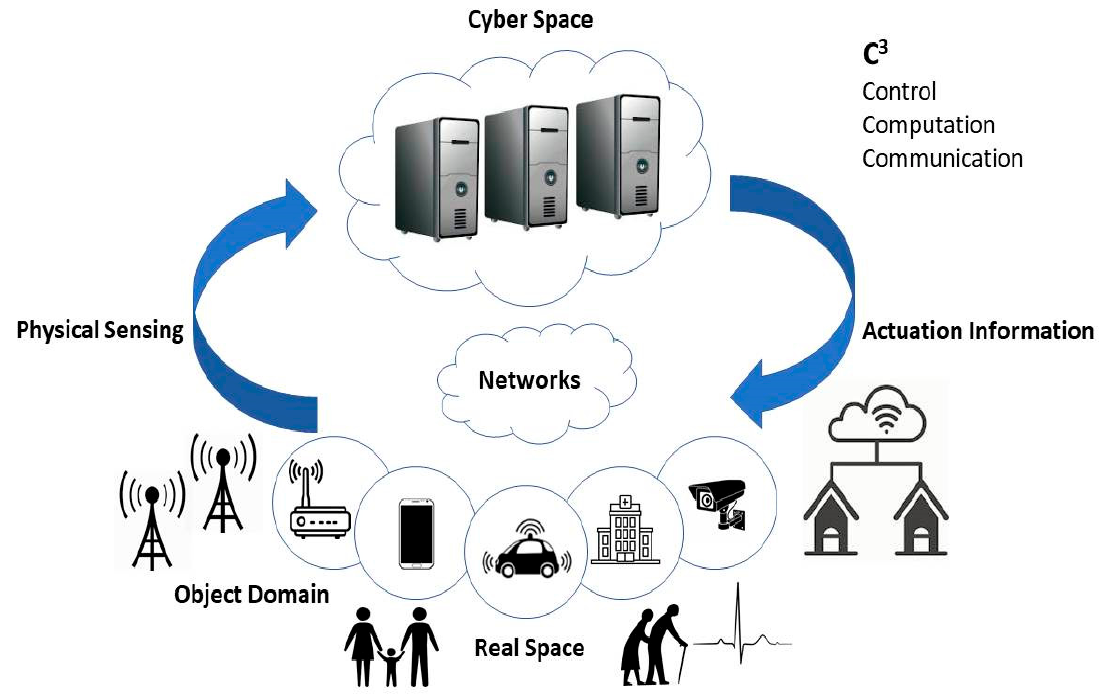
Figure 1. A cyber-physical system.